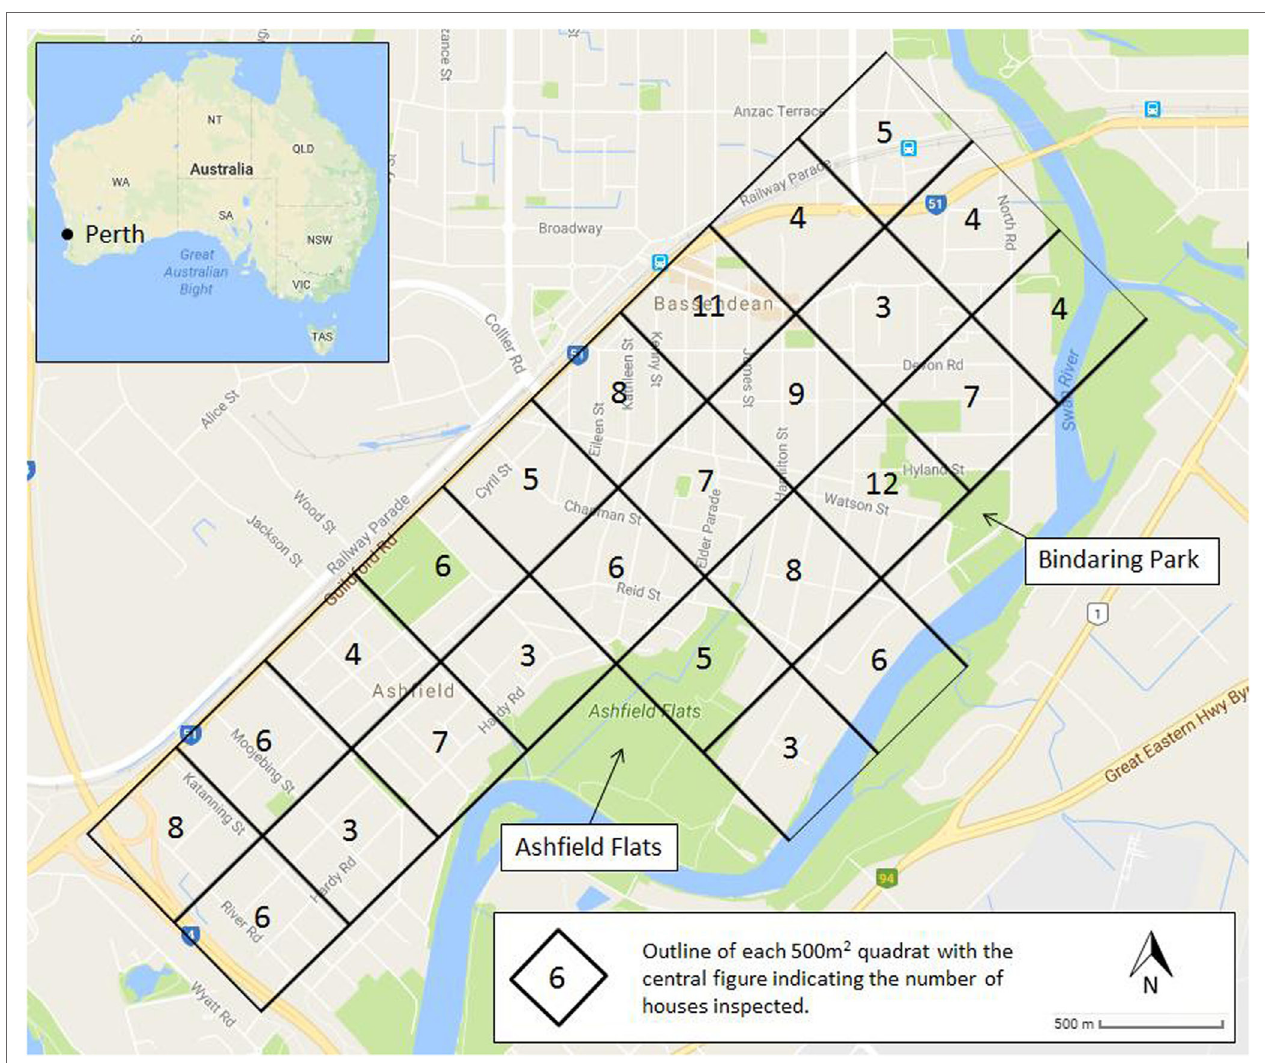
FigUre 1 | The study area within the Town of Bassendean, Perth, WA, Australia showing the 25 quadrats and the number of household inspected within each quadrat (central figure within each